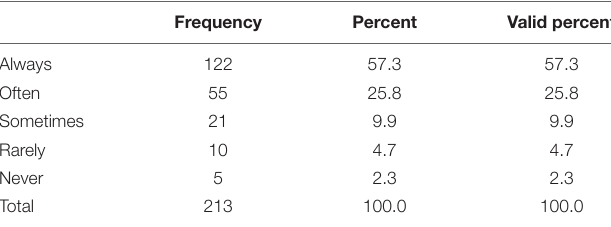
TABLE 5 | I use English for other types of communication (announcements, signs,